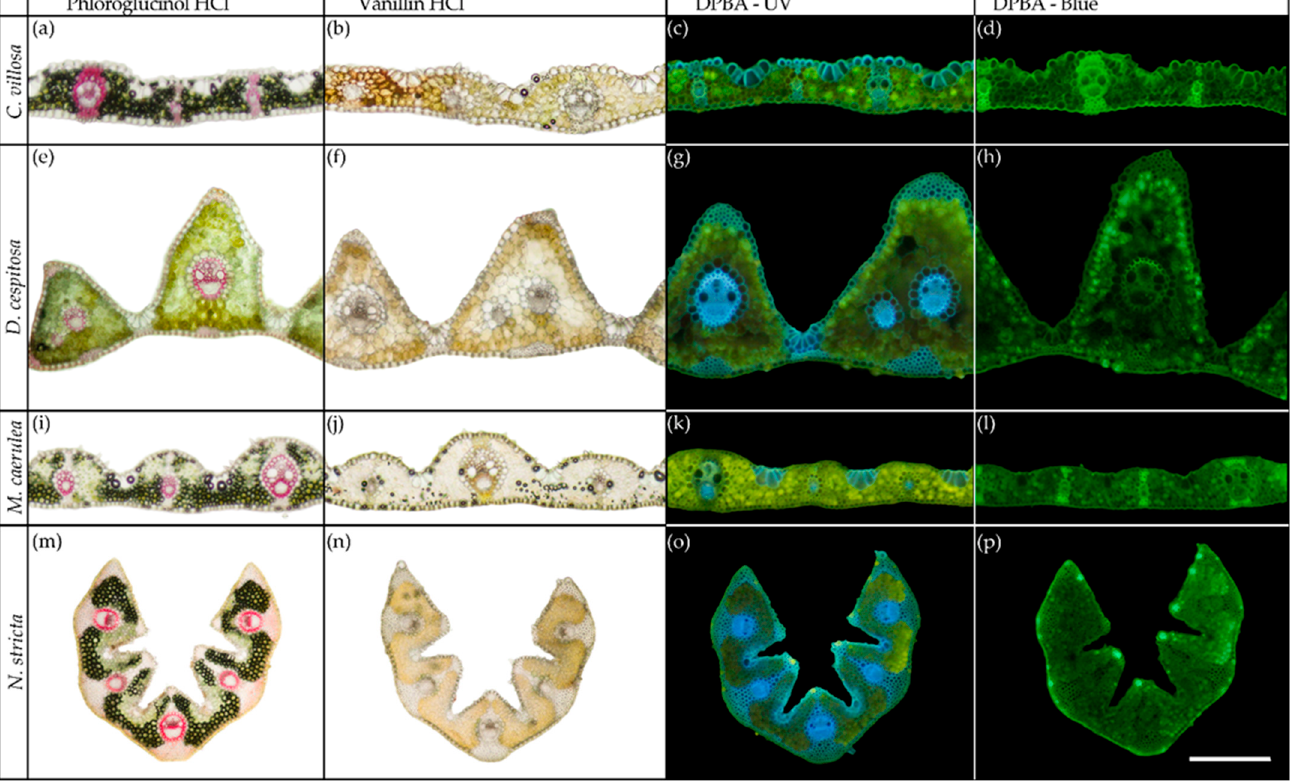
Figure 4. Representative cross-sections of fully developed leaves (August 2020) from the four competing grass species: Calamagrostis villosa [first row: ( a – d )], Deschampsia cespitosa [second row: ( e – h )], Molinia caerulea [third row: ( i – l )], and Nardus stricta [fourth row: ( m – p )]. The sections were taken from the central part of the leaf blades in August 2020. Histochemical tests: Phloroglucinol-HCl (first column: a , e , i , m ) stains lignified cell walls pink, vanillin-HCl (second column: b , f , j , n ) stains condensed tannins red, Naturstoff reagent A (DPBA) enhances yellow autofluorescence of flavonoids and blue autofluorescence of lignins and cell-wall-bound ferulic acid in UV light (third column: c , g , k , o ) and (fourth column: d , h , l , p ) enhances the yellow and green fluorescence of phenolic compounds in blue light excitation. The scale bar is equal to 0.5 mm.